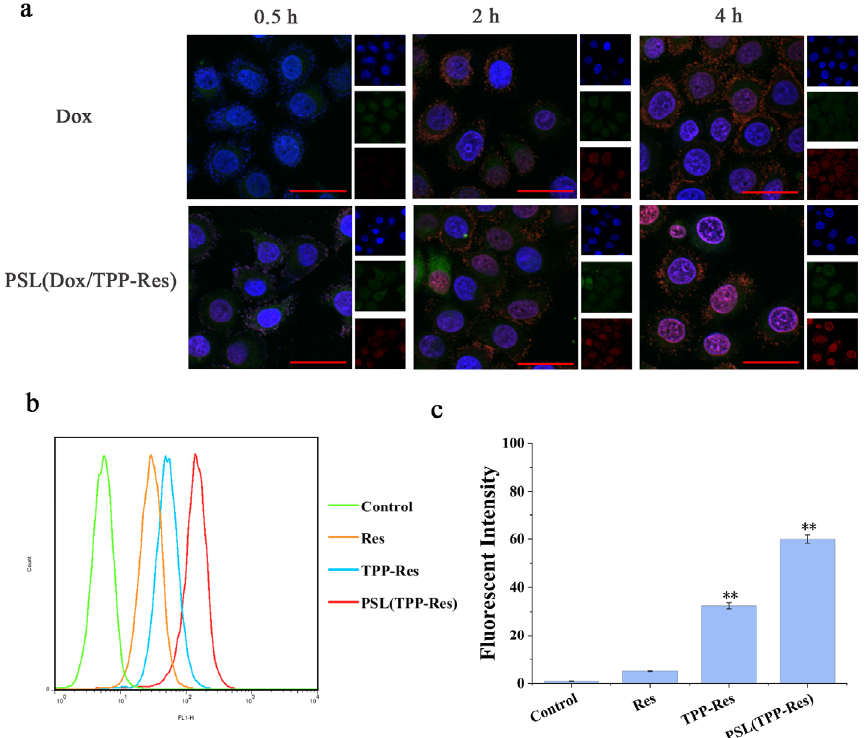
Figure 6. ( a ) Confocal laser scanning microscopy images of CSLCs incubated with PSL (Dox/TPP-Res) and free Dox solution for 0.5 h, 2 h and 4 h (Red: DOX; Green: lysotracker-Green; Blue: Honchest 33258). ( b , c ) Flow cytometry measurement of TPP-Res in mitochondrial fraction in CSLCs treated with different formulations. Data were expressed as mean ± SD (n = 3), ** p < 0.01 compared with the control group. Scale bars represent 50 µ